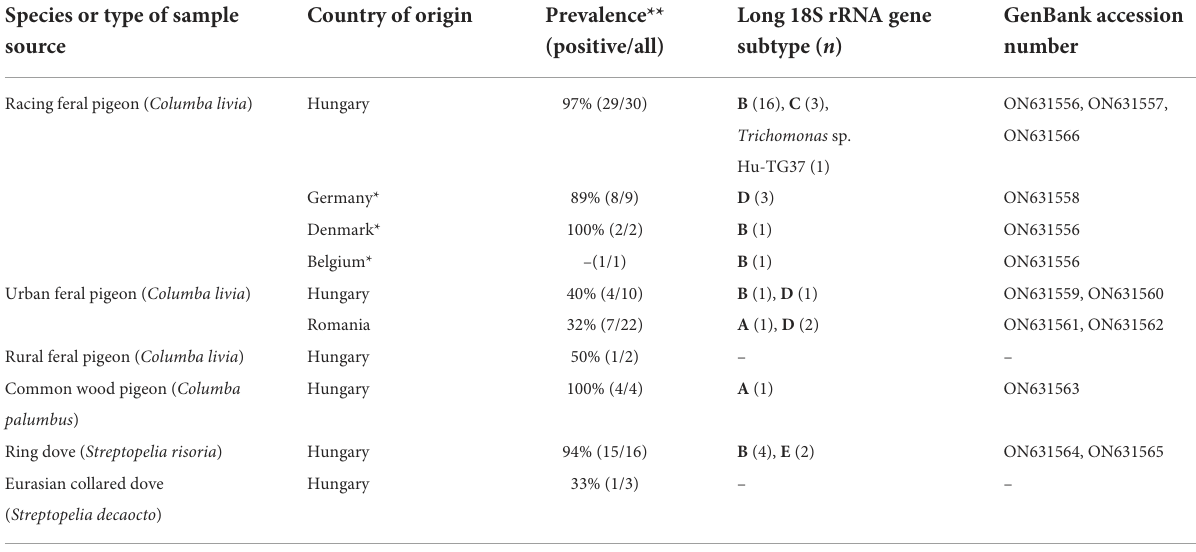
TABLE 1 Results of molecular analyses for the 18S rRNA gene of Trichomonadea according to sample types of columbiform birds. Species or type of sample